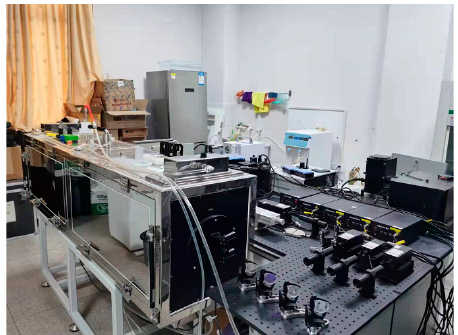
Figure 2. Material composition three-dimensional platform.